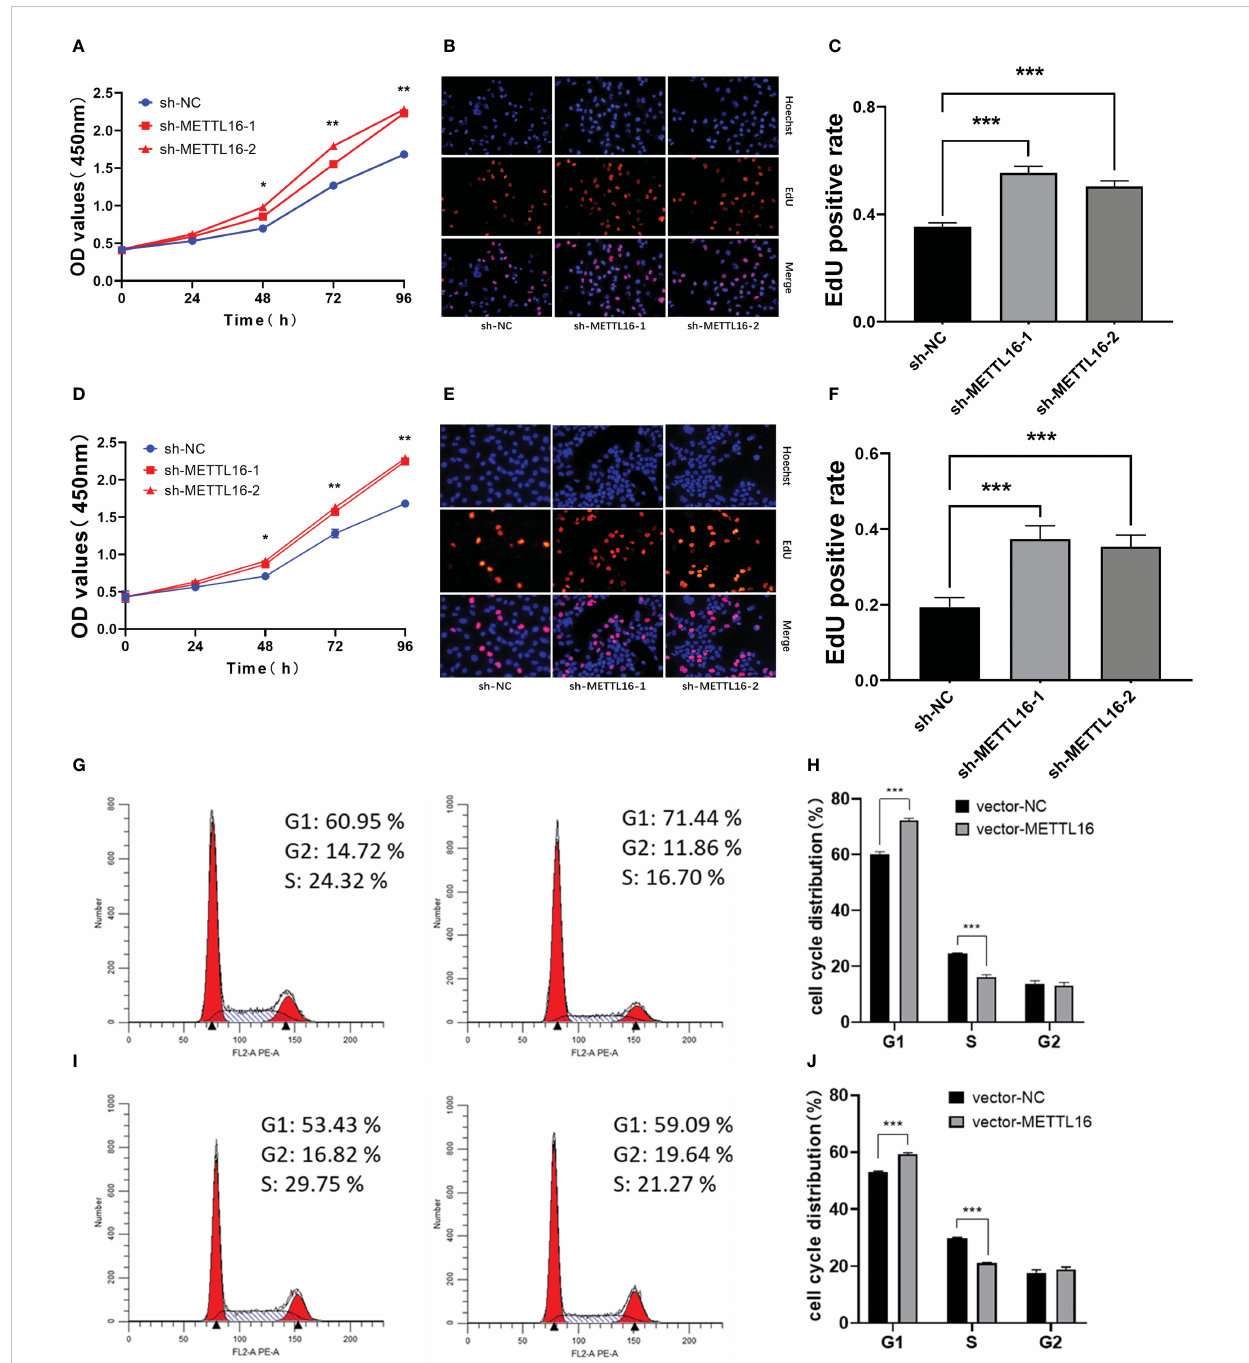
FIGURE 2 Downregulation of METTL16 promotes PC cell proliferation by restraining cells in the G1 phase. CCK-8 assay to assess the effect of METTL16 on PANC-1 cell (A) and CFPAC-1 cell (D) growth. EdU assays were used to assess cell proliferation. The histogram shows the proliferation rates of transfected cells in the corresponding groups: PANC-1 (B, C) ; CFPAC-1 (E, F) . Flow cytometry assays showed that the overexpression of METTL16 signi fi cantly increased the proportion of CFPAC-1 (G, H) and SW1990 (I, J) cells in the G1 phase and decreased the proportion of cells in the S phase. * means p<0.05; ** means p<0.01; *** means